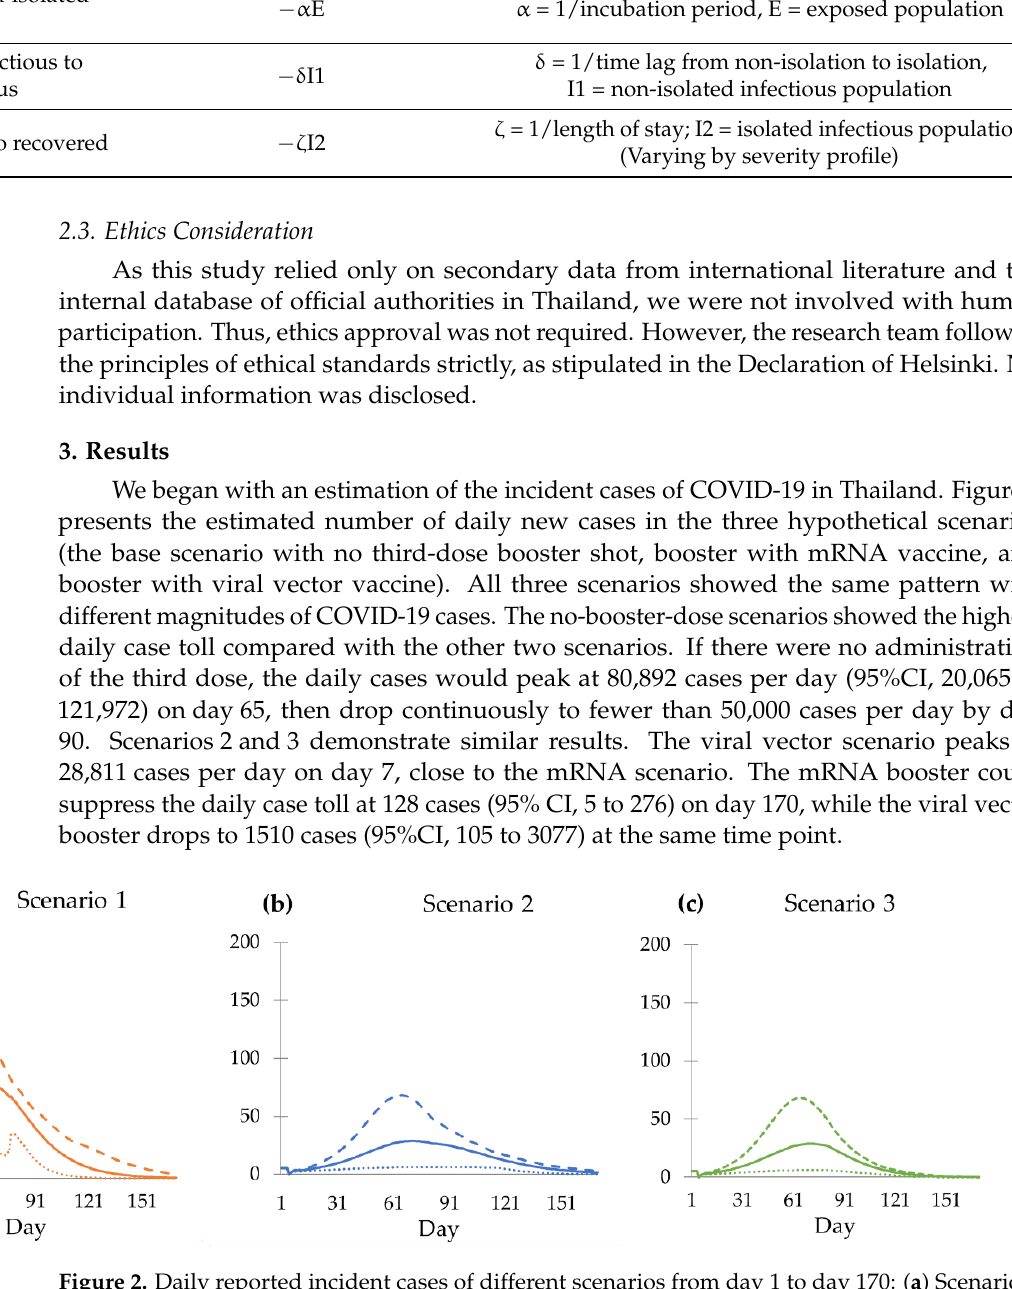
Figure 3. Cumulative cases of all scenarios from day 1 to day 170: ( a ) Scenario 1, no booster dose; ( b ) Scenario 2, viral vector vaccine as booster dose; ( c ) Scenario 3, mRNA vaccine as a booster dose. The solid line shows the mean of the outcome. The dashed line shows the 97.5th percentile of the outcome. The dotted line shows the 2.5th percentile of the outcome.